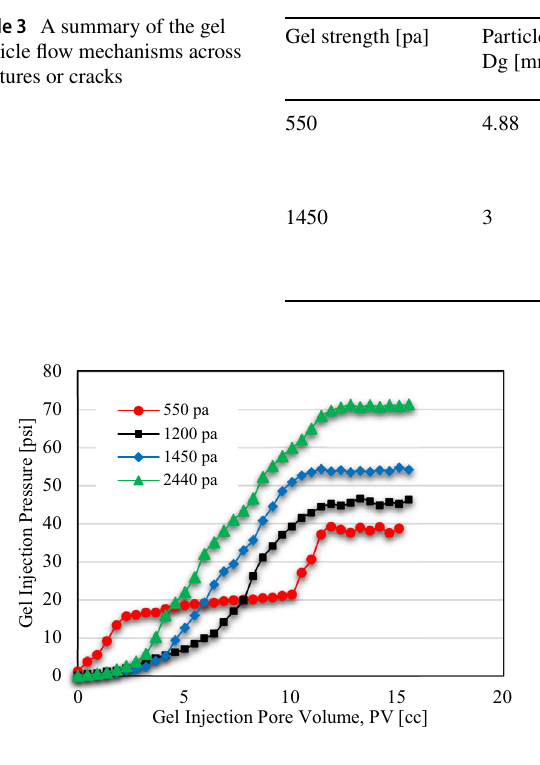
Fig. 10 Particle gel injection (0.5 mm fracture width)